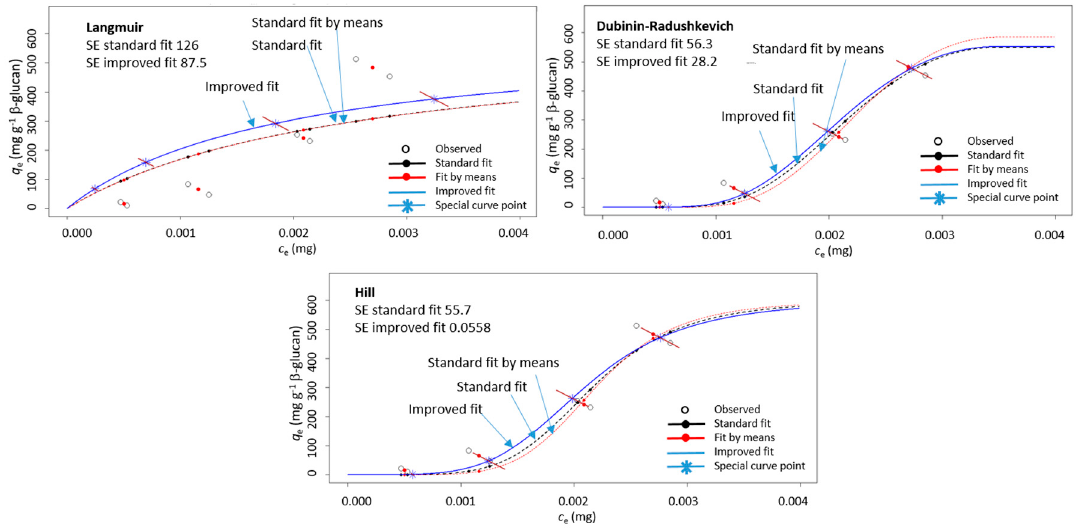
Figure 3. An example of a diagram showing adsorption capacity ( q e ) vs. un-adsorbed polyphenol amount ( c e ) for ( + )-catechin from peel (“Batulenka”) modeled with three isotherms (Langmuir, Dubinin–Radushkevich, and Hill) using improved non-linear regression (improved fit marked with blue, standard fit with black, and standard fit of mean values with red). SE is the standard error